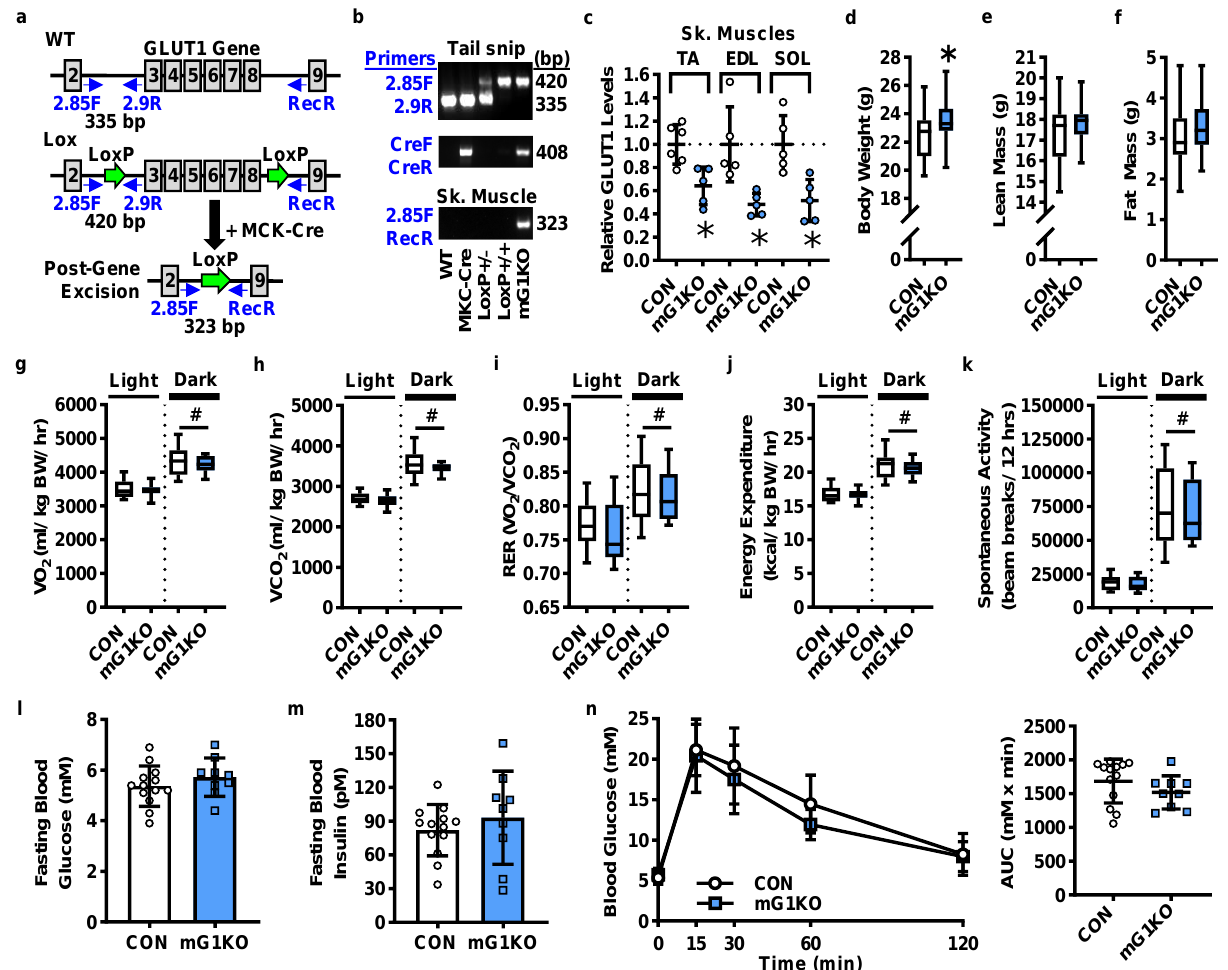
Figure 1. Muscle-specific GLUT1 knockout (mG1KO) mice are viable but do not exhibit impairments in body weight, body composition, whole body metabolism, spontaneous physical activity, or sys- temic glucose regulation. ( a ) Schematic representation of the GLUT1 gene including the location of the LoxP sites and the primers used for mouse genotyping and post-gene recombination. ( b ) Rep- resentative images of the mouse genotyping PCR reaction products using DNA isolated from tail snips (top 2 images). The excision of GLUT1 exons 3 – 8 was confirmed in skeletal muscle samples obtained from wild-type (WT), muscle creatine kinase promoter-driven Cre recombinase (MCK- Cre) transgenic, GLUT1 LoxP+/ − , GLUT1 LoxP+/+, and mG1KO mice post-euthanasia (bottom im- age). ( c ) GLUT1 mRNA levels assessed in tibialis anterior (TA), extensor digitorum longus (EDL), and soleus (SOL) muscles by RT-qPCR. N = 5 – 6 muscles/group. ( d – f ) In female control (CON) and mG1KO mice, the following were assessed: ( d ) body weight; ( e ) lean mass; and ( f ) fat mass. N = 22 – 34 mice/group. ( g – k ) Female mice were individually housed in metabolic cages at 21 – 22 °C for in- direct calorimetry measures in both the light and dark cycles. Measures included: ( g ) oxygen con- sumption (VO 2 ); ( h ) carbon dioxide production (VCO 2 ); ( i ) respiratory exchange ratio (RER); and ( j ) energy expenditure. ( k ) Infrared sensors detected spontaneous physical activity. N = 14 – 24 mice/group. ( l – n ) Female mice were fasted overnight. Blood was collected from the tail to assess: ( l ) glucose and ( m ) insulin levels. ( n ) Mice received an intraperitoneal injection of glucose (2 g/kg lean mass), and blood glucose measured 15, 30, 60 and 120 min later. The area under the curve was cal- culated (inset). N = 9 – 13 mice/group. Data are presented as individual data points with the mean ± standard deviation ( c,l – n inset); box and whisker plots with error bars denoting min and max ( d – k ); and mean ± standard deviation ( n ). Statistical significance was defined as p < 0.05, determined using t -tests ( c – f , and l – n ) or repeated measures two- way ANOVA with Sidak’s posthoc analysis ( g – k ), an d denoted by ‘*’ vs . control (CON) mice or “#” vs . main effect (light vs. dark cycle).